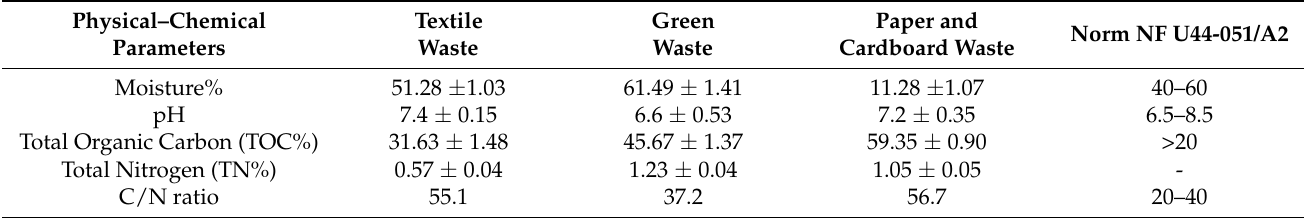
Table 1. Physical–chemical characterization of the